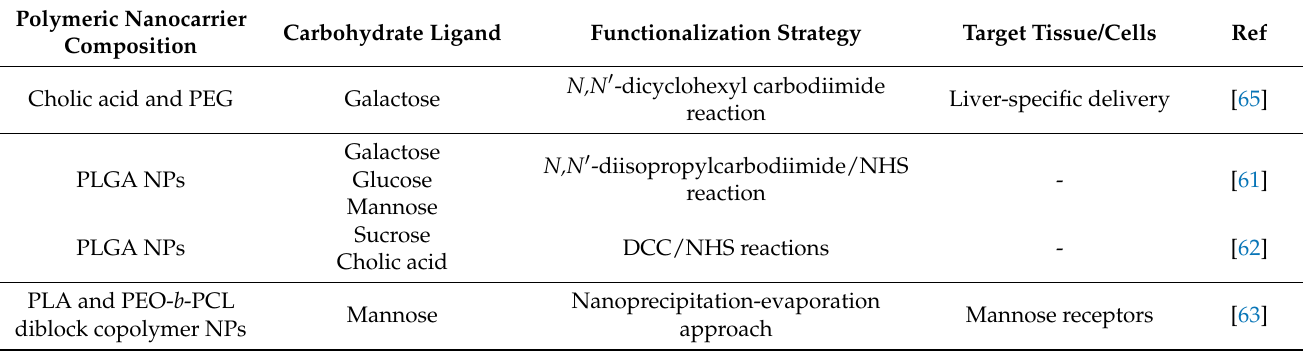
Table 1. List of developed carbohydrate-functionalized polymeric